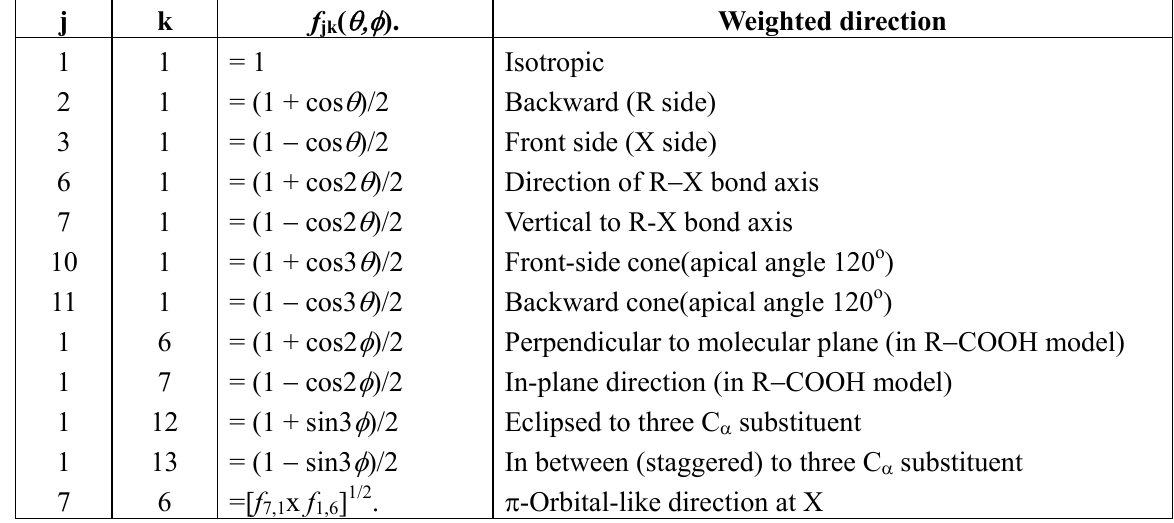
Table 1. Weight-functions f